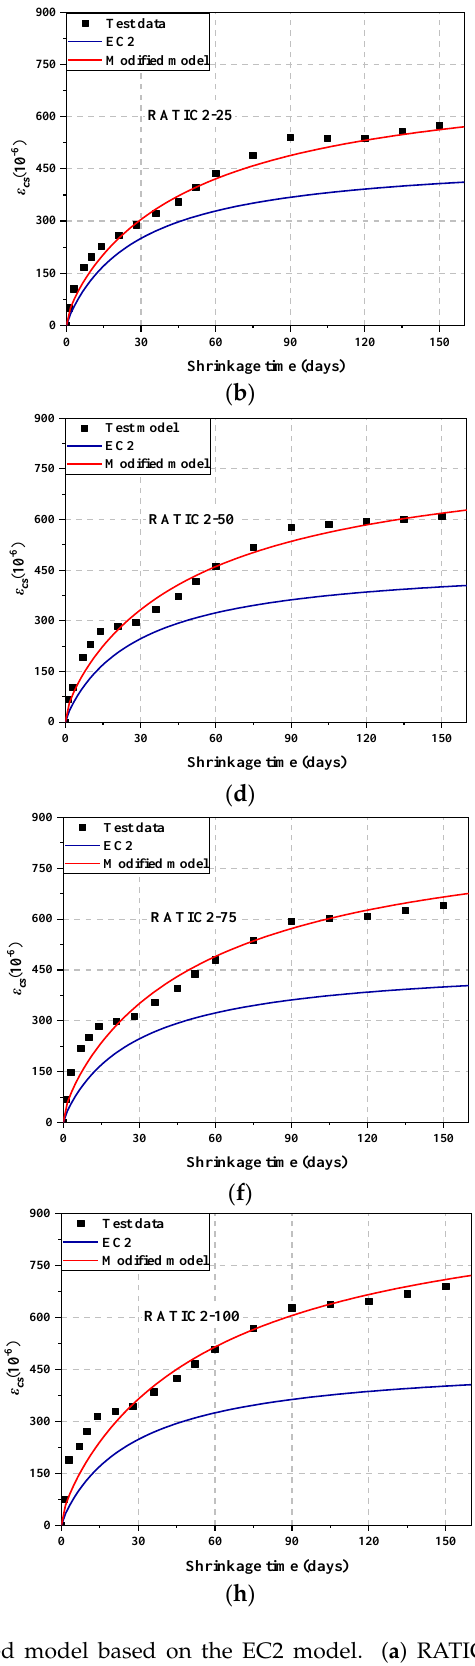
Figure 14. The predicted results of EC2 model and the modified model based on the EC2 model. ( a ) RATIC1-25; ( b ) RATIC2-25; ( c ) RATIC1-50; ( d ) RATIC2-50; ( e ) RATIC1-75; ( f ) RATIC2-75; ( g ) RATIC1-100; ( h )